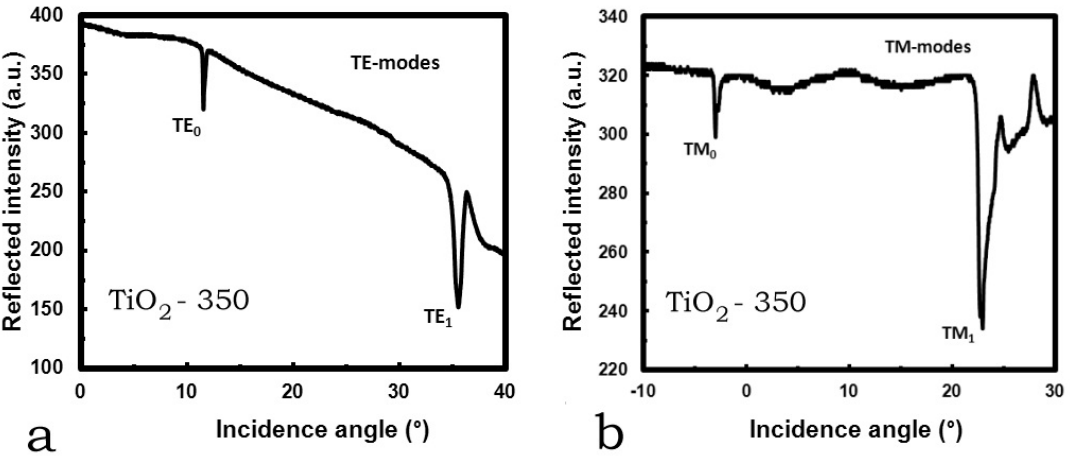
Figure 4. Typical guided mode spectra of TiO ( b ) transverse magnetic (TM) polarizations.